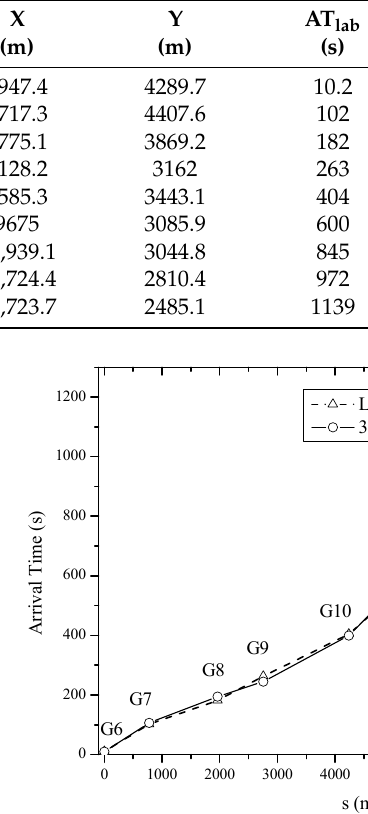
Figure 4. Comparison of the wave arrival time between laboratory ‐ scale model [8,46] and the 3D model against the river centerline (i.e., s).